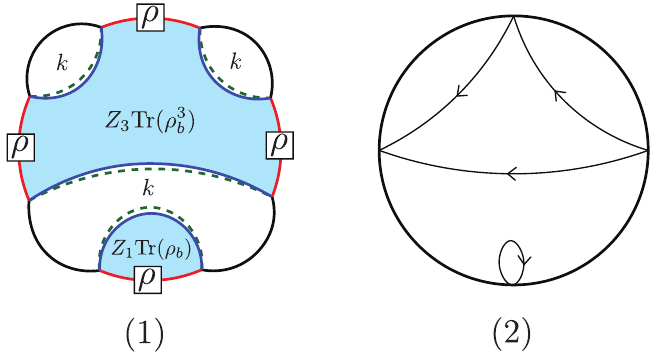
Figure 3 . (1) The contribution from one of the topologies for the entropy term has been de- composed into the contribution from each section of the planar diagram. Each frozen index loop contributes k while the blue, shaded regions representing a connected disk joining n boundaries con- tribute Z and Tr( ρ n ) from the bulk action and the fluctuating index contraction respectively. n code (2) The same geometry represented as a permutation in the symmetric group S